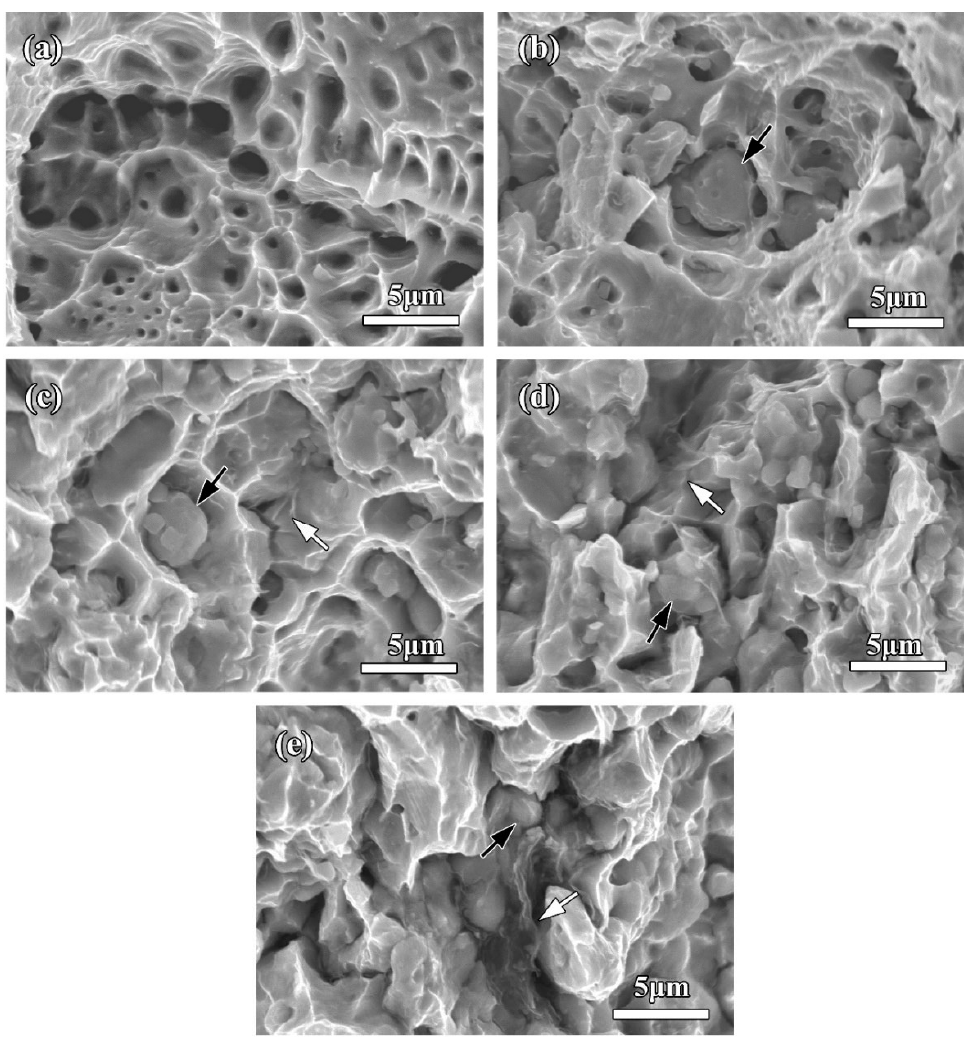
Figure 13. SEM micrographs of tensile fractography of the sintered pure copper and bulk compacts: ( a ) pure copper, ( b ) 0rGO, ( c ) 1rGO, ( d ) 2rGO, ( e ) 3rGO; where the white and black arrows mark the rGO nanosheets and Fe microspheres on the tensile fractography, respectively.